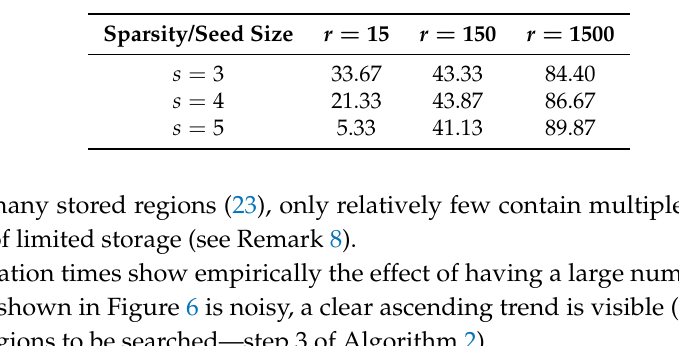
Table 2. Number of regions as a percentage of the total number of signals ( [ % ] ).